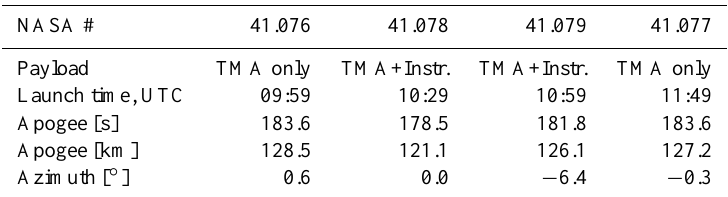
Table 1. Parameters for four sounding rockets launched on 18 February 2009 from Poker Flat, Alaska. Azimuth is measured clockwise from